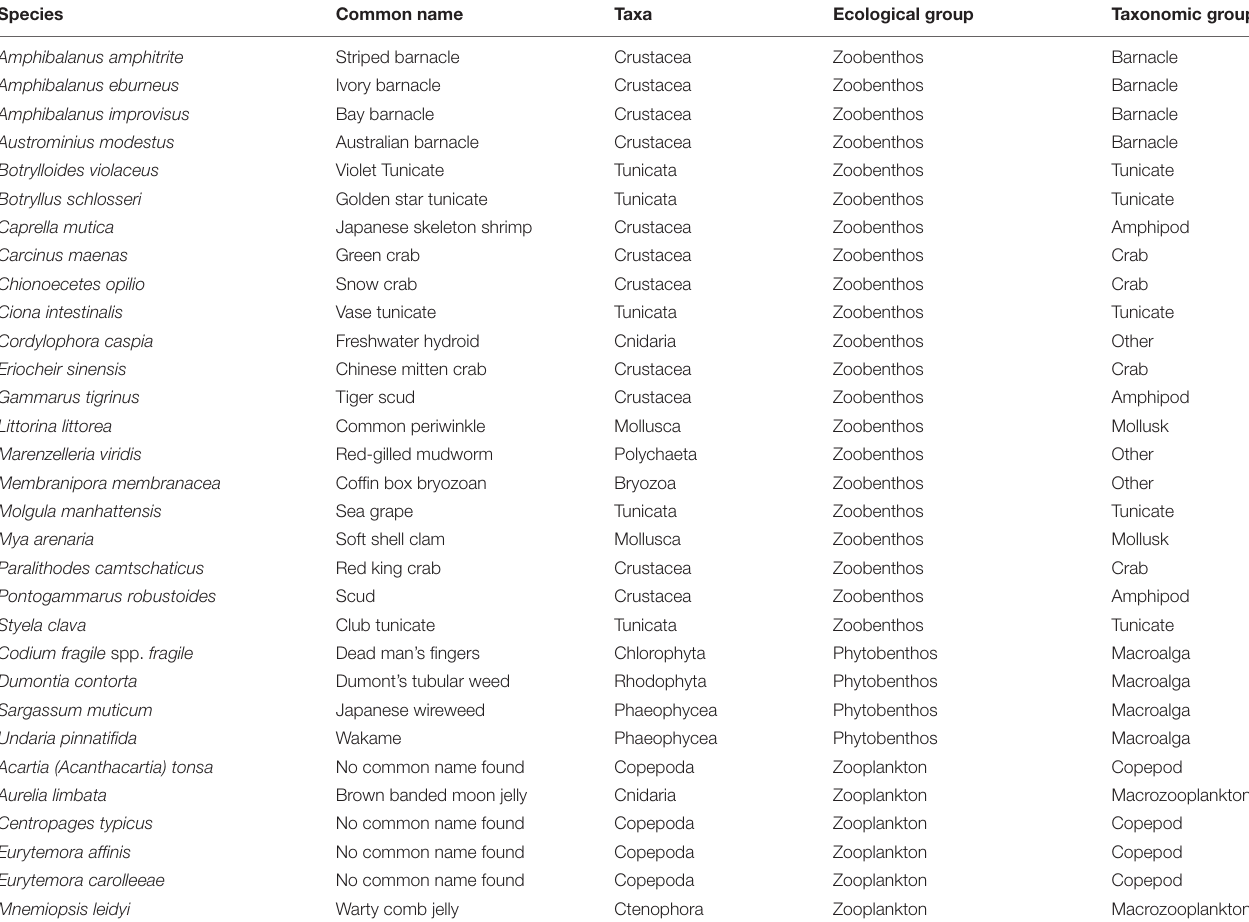
TABLE 1 | Species ranked using the CMIST